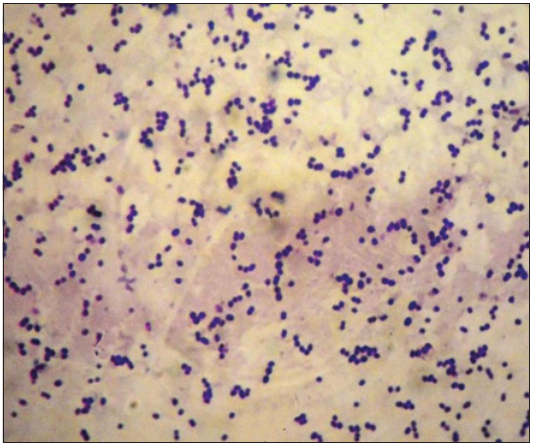
Figure-1: Microscopical examination of Streptococcus equi stained with Gram-stain showing Gram-positive cocci arranged in pairs and chains (Oil,